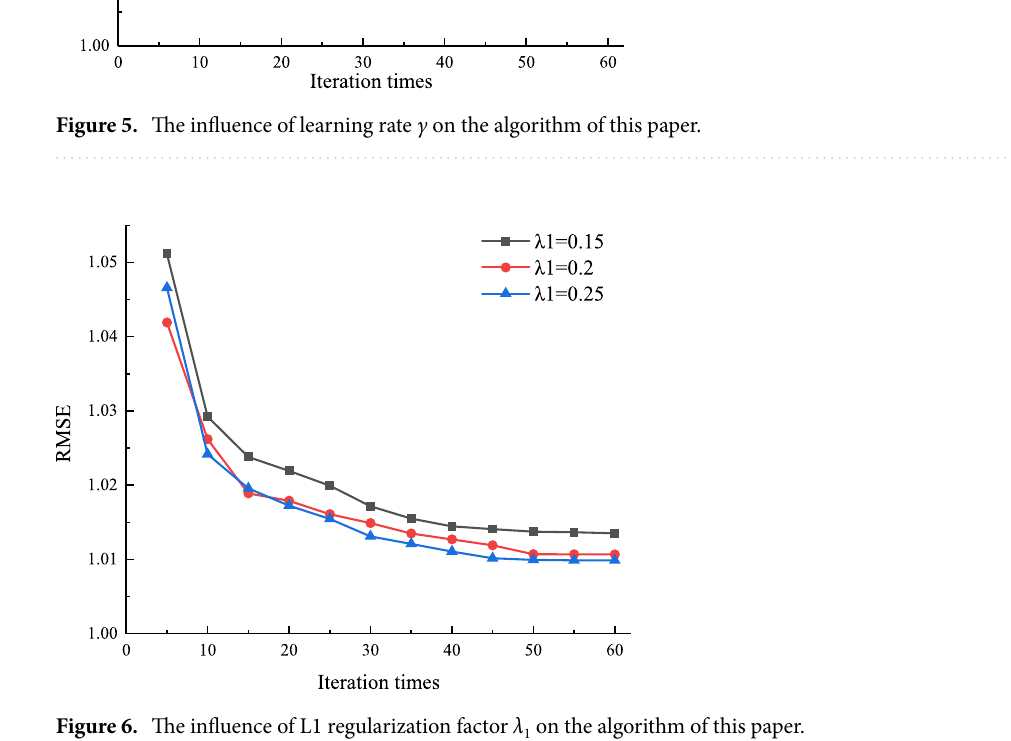
Figure 6. The influence of L1 regularization factor λ 1 on the algorithm of this